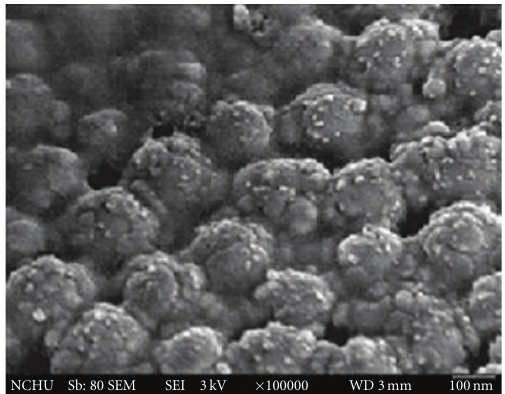
Figure 9: SEM image after N3 soaking.